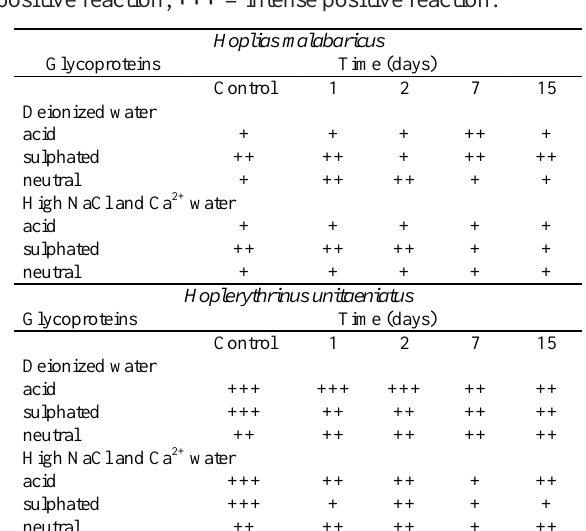
Table 1. Mucosubstances in the mucous cells of the gill epithelium of H. malabaricus and H. unitaeniatus of the controls groups and groups maintained in deionized water and water with high ions (NaCl + Ca 2+ ) concentration. 0 = negative reaction; + = weak positive reaction; ++ = moderate positive reaction; +++ = intense positive